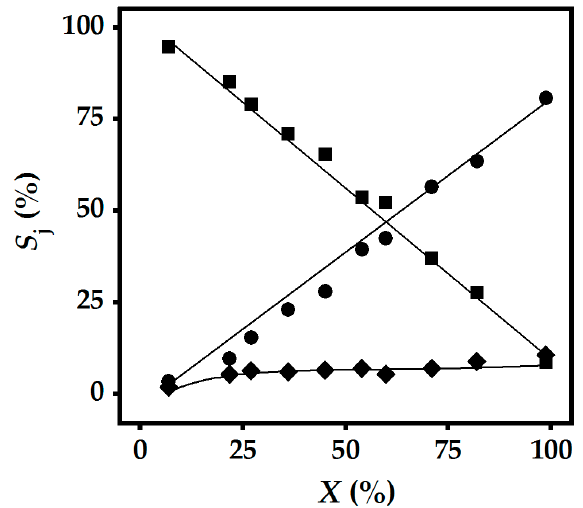
Figure4. Variationofselectivity( S j (%), j = 3-buten-1-ol( (cid:4) ), 1-butanol( (cid:8) ), crotylalcohol + butyraldehyde Figure 4. Variation of selectivity ( S j (%), j = 3-buten-1-ol ( ■ ), 1-butanol ( ● ), crotyl alcohol+ butyraldehyde ( (cid:117) ) with conversion ( X (%)) in hydrogenation of 3-butyn-1-ol over Pd / Al 2 O 3 . Note: solid lines provide (  )) with conversion ( X (%)) in hydrogenation of 3-butyn-1-ol over Pd/Al 2 O 3 . Note: solid lines a guide to aid visual assessment. Reaction conditions : T = 373 K, p = 1 provide a guide to aid visual assessment. Reaction conditions : T = 373 K, p = 1 atm.